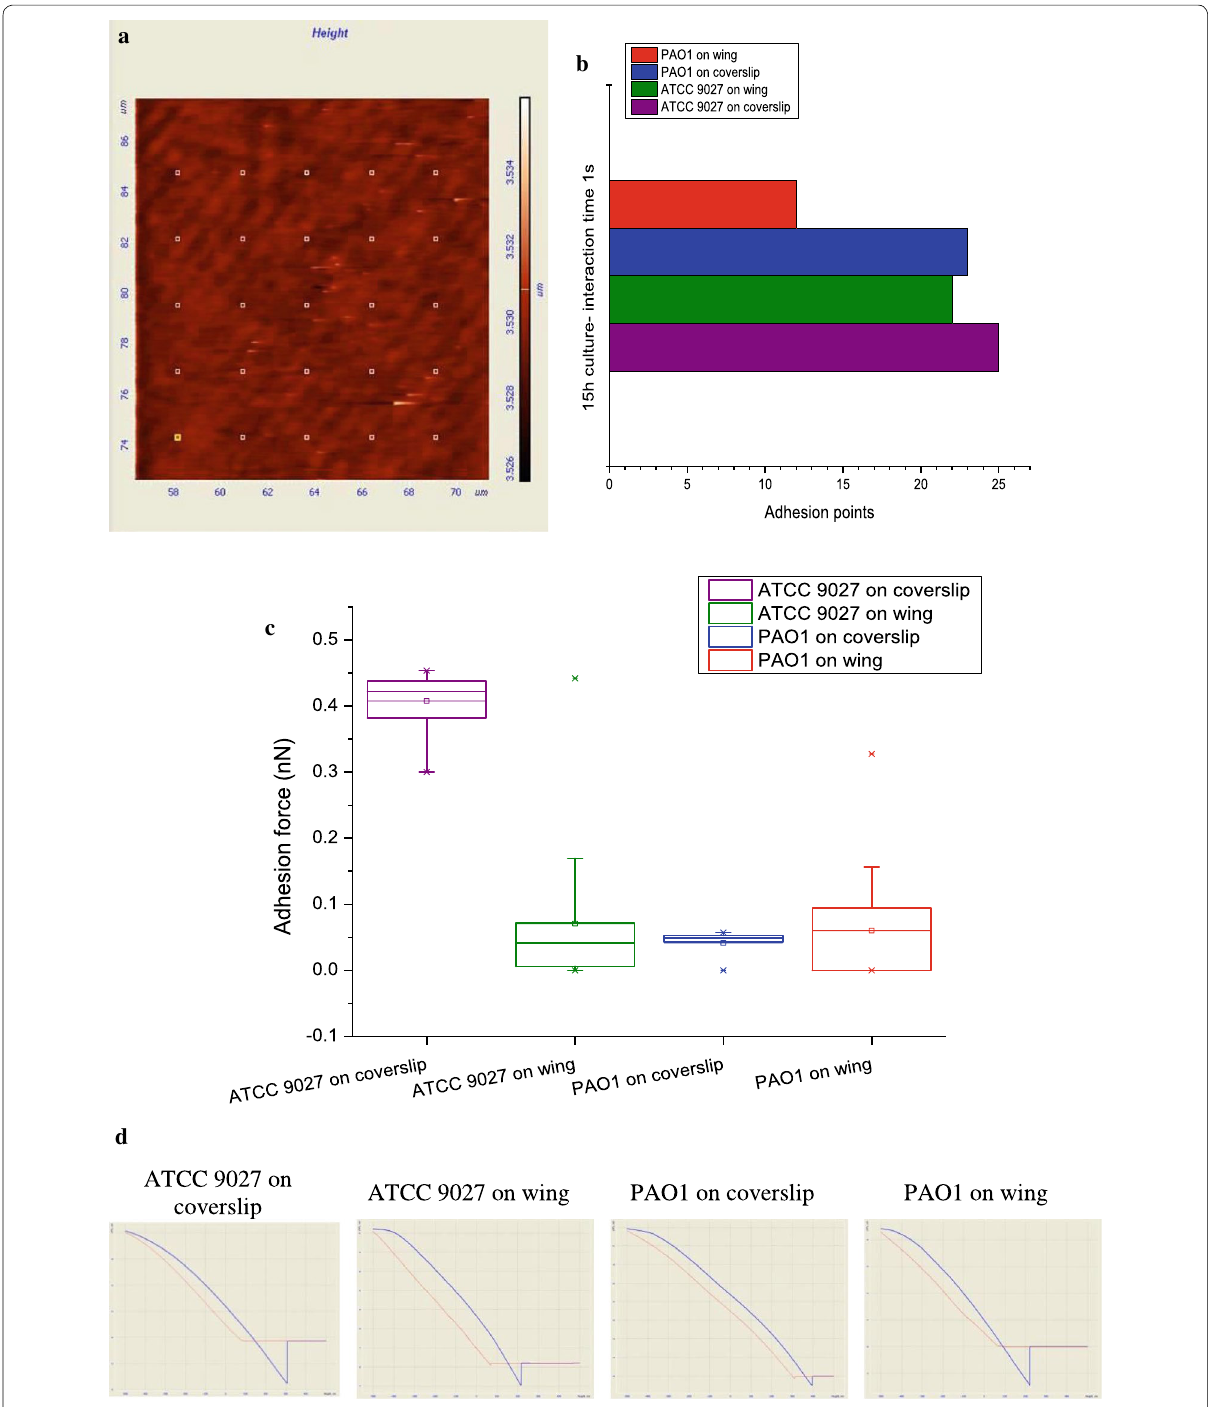
Fig. 4 a Representative image showing the random 25 regions (white square dots) chosen on the surface of wing to measure the adhesion propensity of the P. aeruginosa strains. b Number of points on the surface of coverslip and wing to which PAO1 and ATCC 9027 showed adhesion. c Adhesion force exerted by ATCC 9027 and PAO1 on coverslip and wing was represented using Box–Whisker plot. Box represents the distribution range of values. Dark line inside the box represents 50% values. Thin line in the box represents average value. Square dot represents median value and, the bars represent standard deviation. d Representative force-distance curves of PAO1 and ATCC 9027 on coverslip and wing surface. Red line represents the probe-approach and blue line represents the